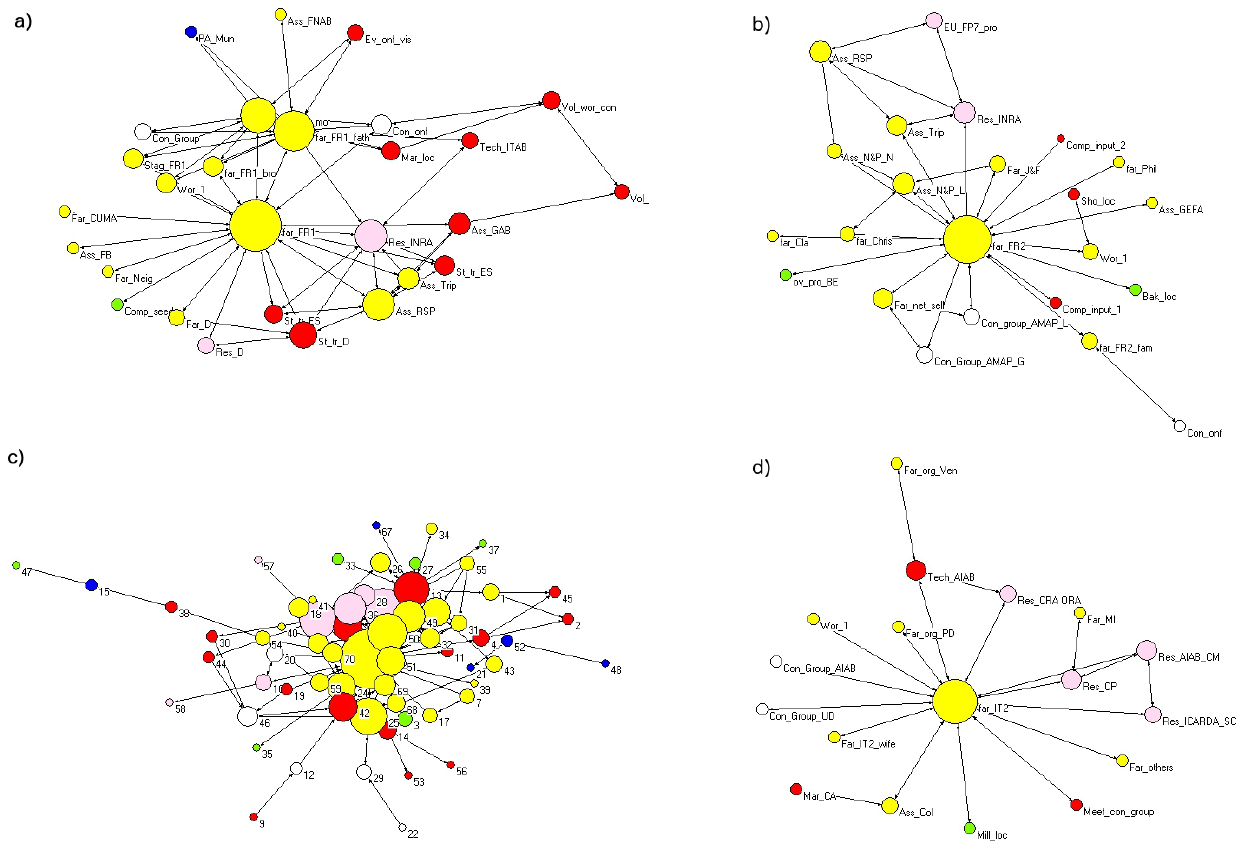
Figure 1. Farmers knowledge networks ( a) FR1 b) FR2 c) IT1 d) IT2 ) by number of connections and economic sectors (Agriculture (yellow), Processing industry (green), Services (red) Public Administration (blue), Research (pink) Households (white)). The size of the circle is related to the number of connections that each node has with others, while the lengths of the connections do not have any significance. The graphs are developed following an ego network analysis approach and using the program “Pajek”. See Appendix for a complete list of